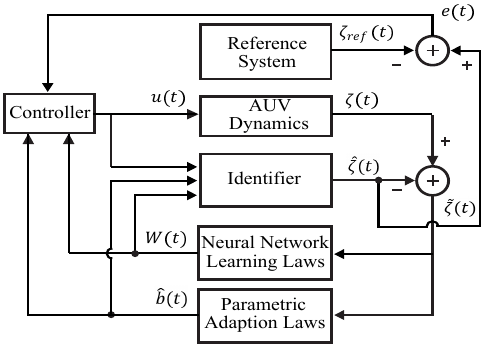
Figure 2. Block diagram of the closed-loop